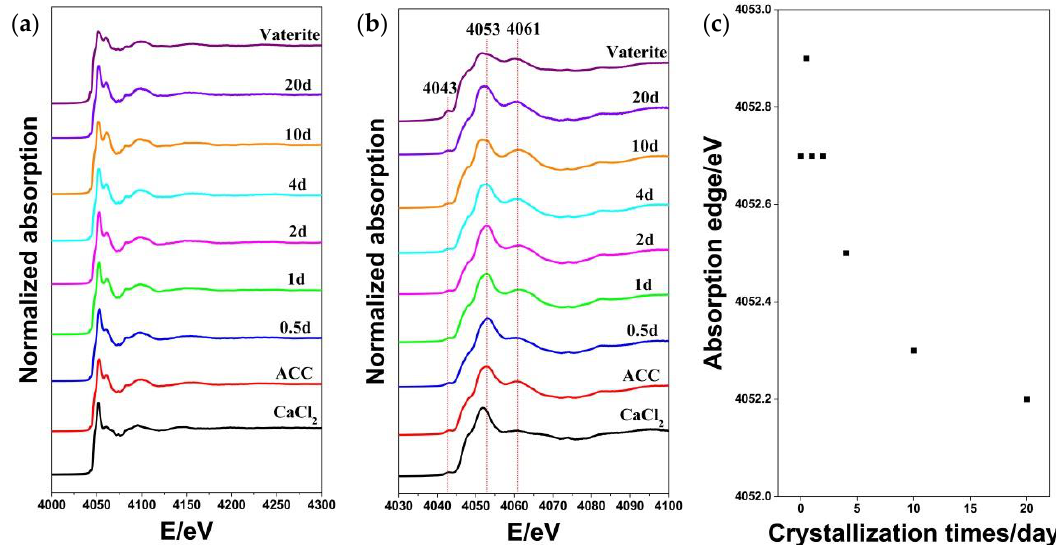
Figure 1. ( a ) Ca K-edge X-ray absorption near edge structure (XANES) spectra of CaCl 2 , proto-vaterite amorphous calcium carbonate (ACC), samples crystallized for different times and well-crystalline vaterite reference. ( b ) Magnified spectra for energy range between 4030 to 4100 eV. ( c ) The corresponding positions of the absorption edges of ACC and samples crystallized for different times. We marked the samples according to their crystallization times in the figures.